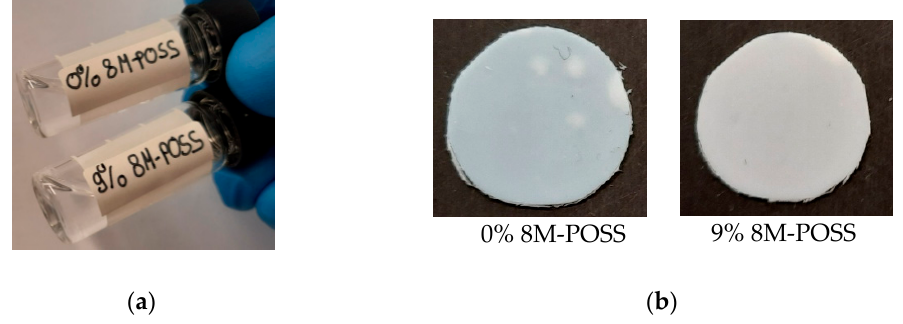
Figure 3. Optical images of ( a ) photocurable compositions in solvents mixture (70 wt.% of EMImNTf 2 + PC): TATT + PETMP (0% 8M-POSS) and TATT + PETMP + 9 wt.% of 8M-POSS (9% 8M-POSS) and ( b ) ionogels poly(TATT + PETMP) and poly(TATT + PETMP + 9 wt.% of 8M-POSS) with 70 wt.% EMImNTf 2 + PC.